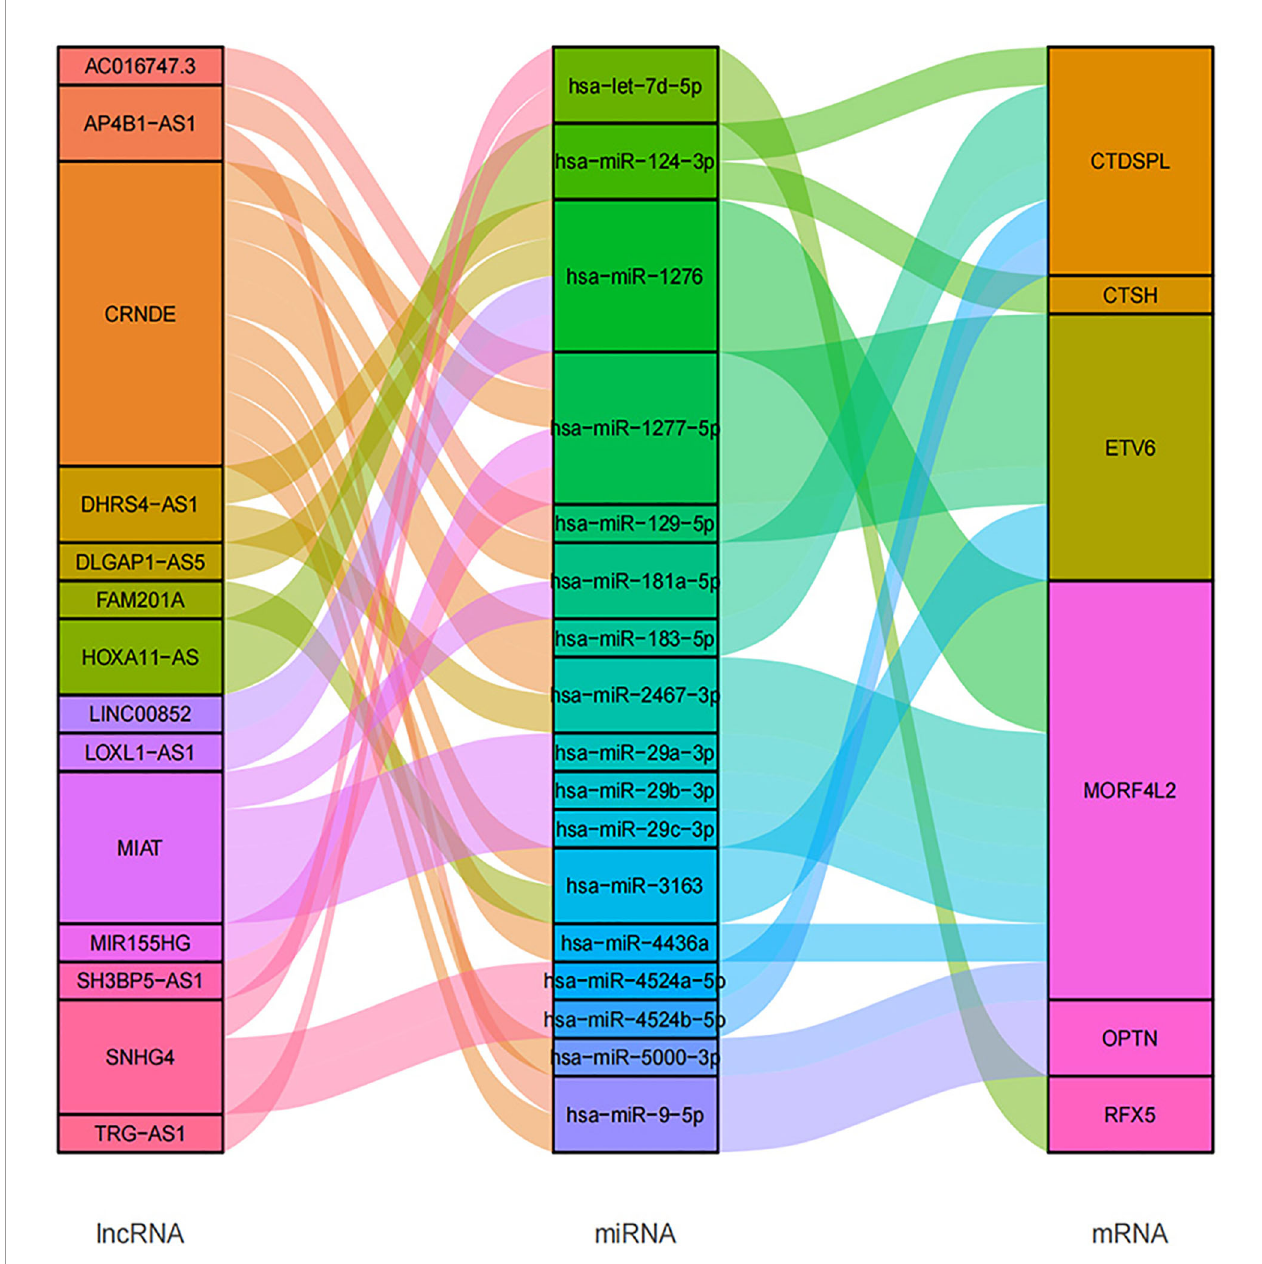
FIGURE 11 | CeRNA network plot based on 11 prognosis signature genes and RT response related